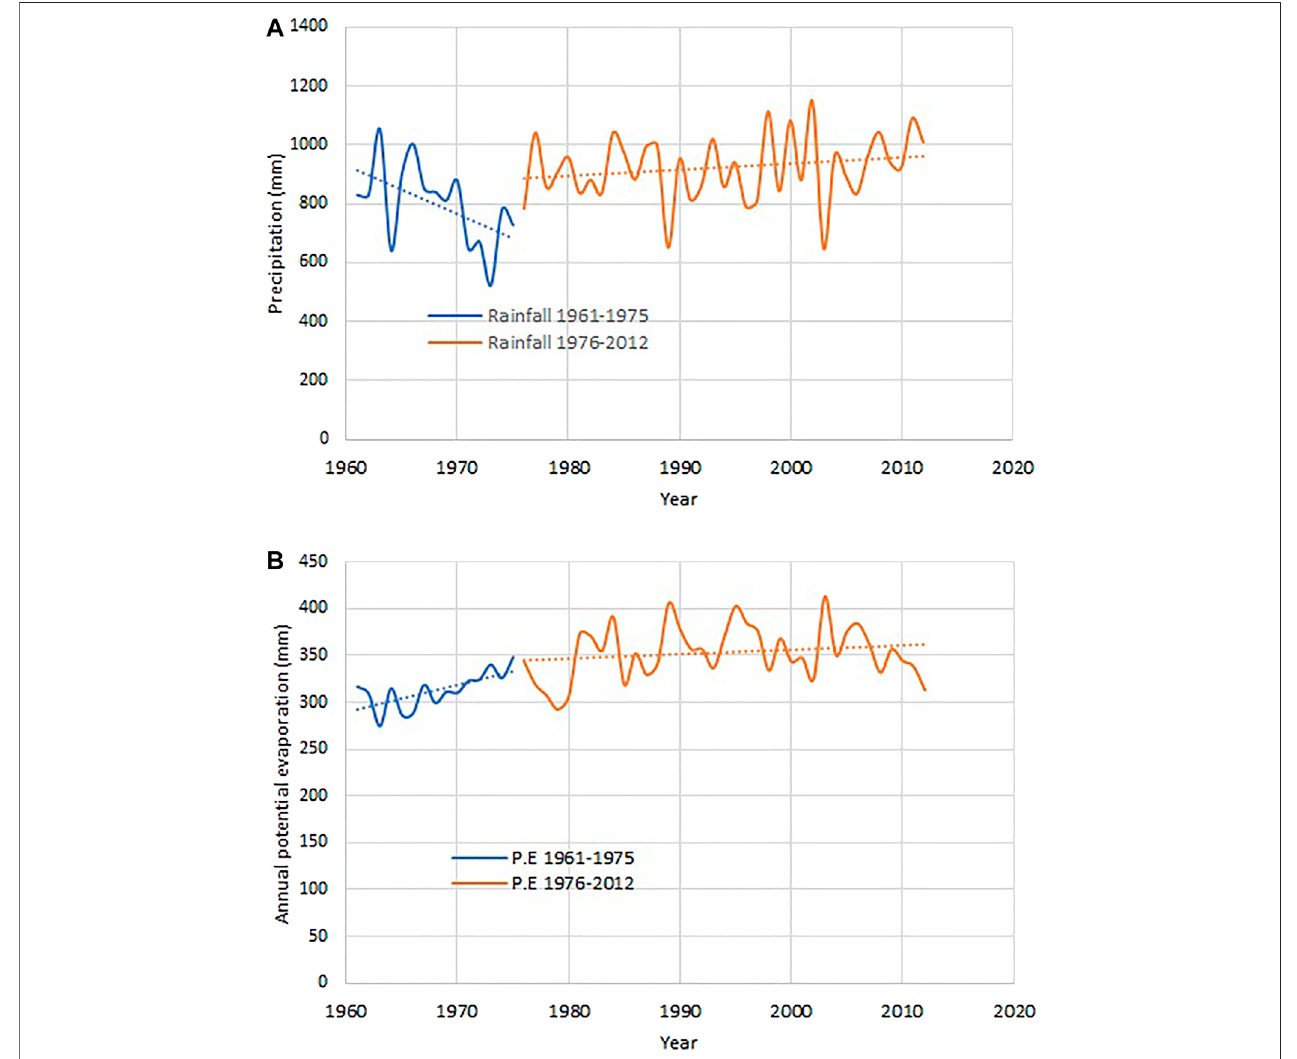
FIGURE 4 | (A) Average annual precipitation; and (B) average daily potential evaporation over the Eden catchment for pre-1976 for the period (1961 – 1975), and post-1976 periods (1976 – 2012).